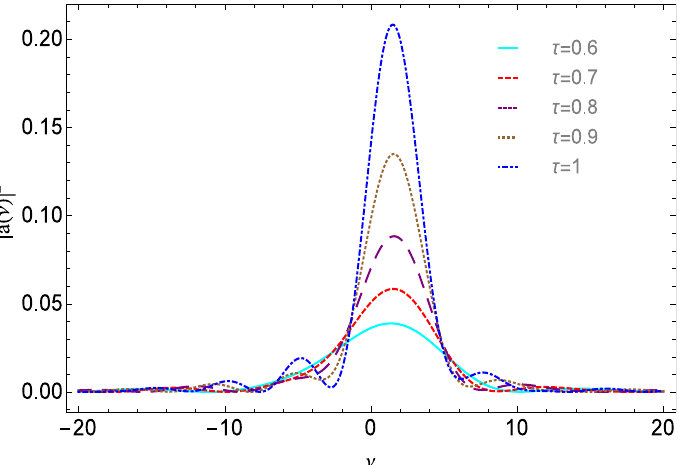
Figure 1. Square modulus of the dimensionless amplitude vs. the detuning parameter for g 0 = 0.5 and different values of τ : ( 0.5,0.6,0.7,0.8,0.9,1 ) . The intensity grows with incresing dimension- less